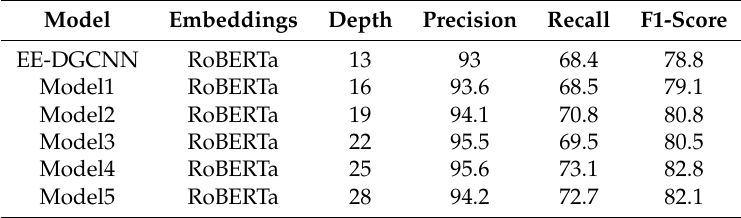
Table 3. Comparison of different network depths.